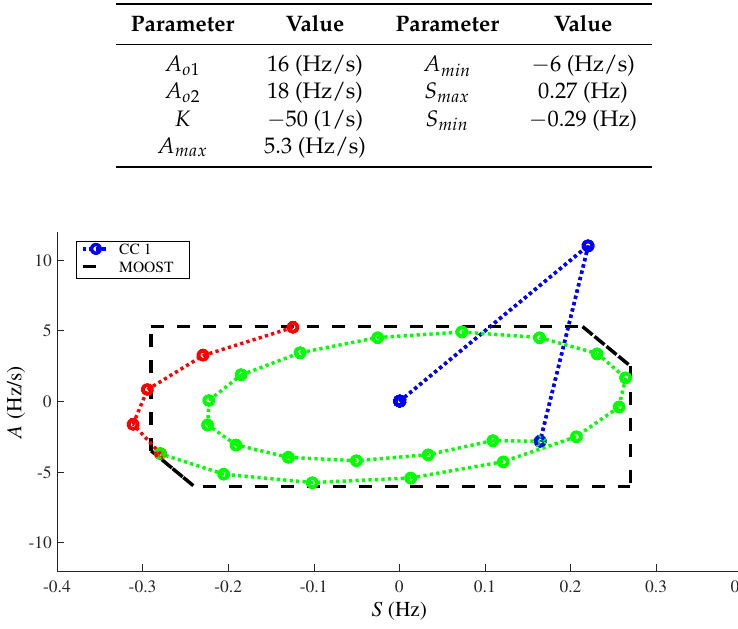
Figure 9. Resulting MOOST normal operation